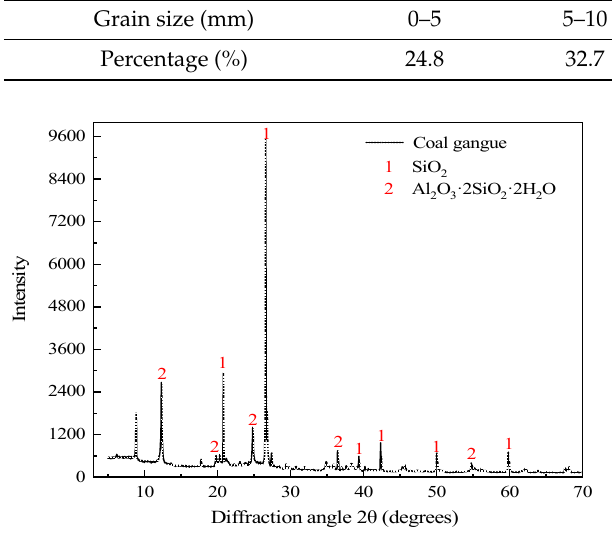
Figure 1. XRD diffraction qualitative analysis pattern of coal gangue.